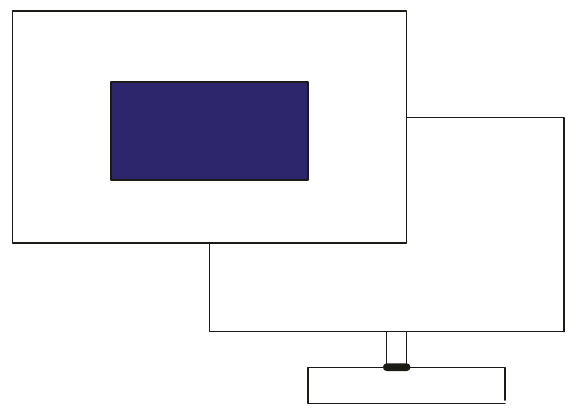
Figure 2: Structure of antenna feed